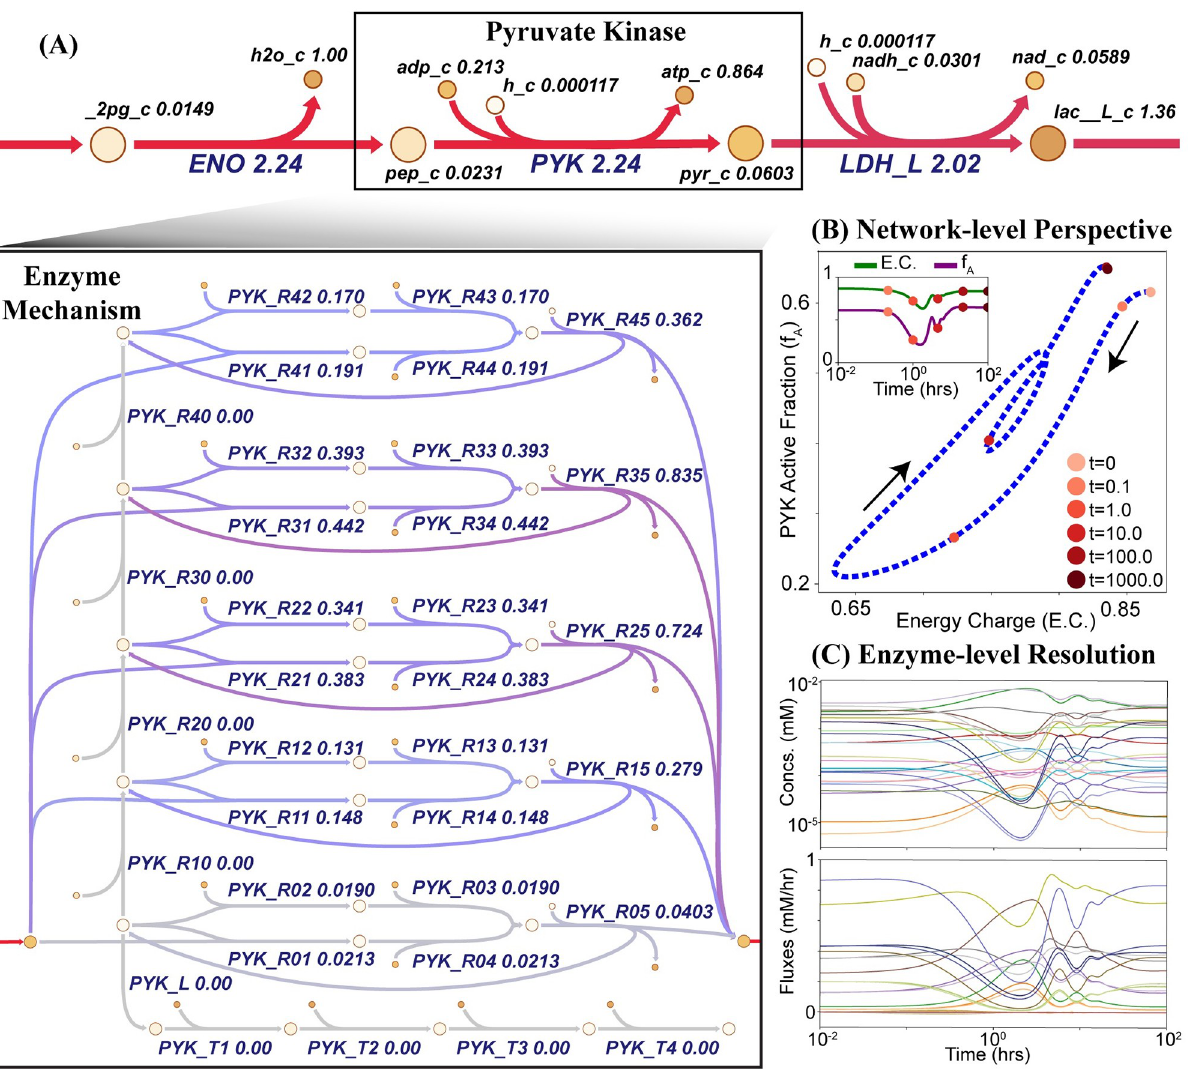
Fig 2. Enzyme modules are explicit representations of enzymatic regulatory mechanisms. (A) The reaction catalyzed by pyruvate kinase is replaced with the stoichiometric description of the enzymatic mechanism. The steady state values obtained after simulating a 50% increase of ATP utilization are mapped onto a metabolic pathway map drawn using Escher [44]. The colors represent flux values and range from red to purple to gray, with red indicating higher flux values and gray indicating lower flux values. (B) Enzyme modules provide a network-level perspective of regulation mechanisms by plotting systemic quantities against fractional states of enzymes as described in Yurkovich et al. [24]. (C) The different signals of the enzyme module can be observed to provide enzyme-level resolution of the regulatory